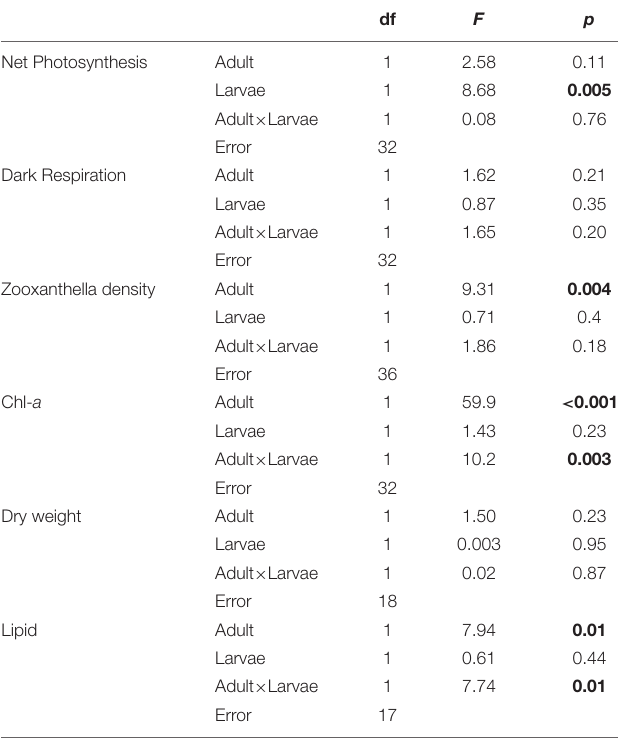
TABLE 3 | Two-way ANOVA table for larval experiments.